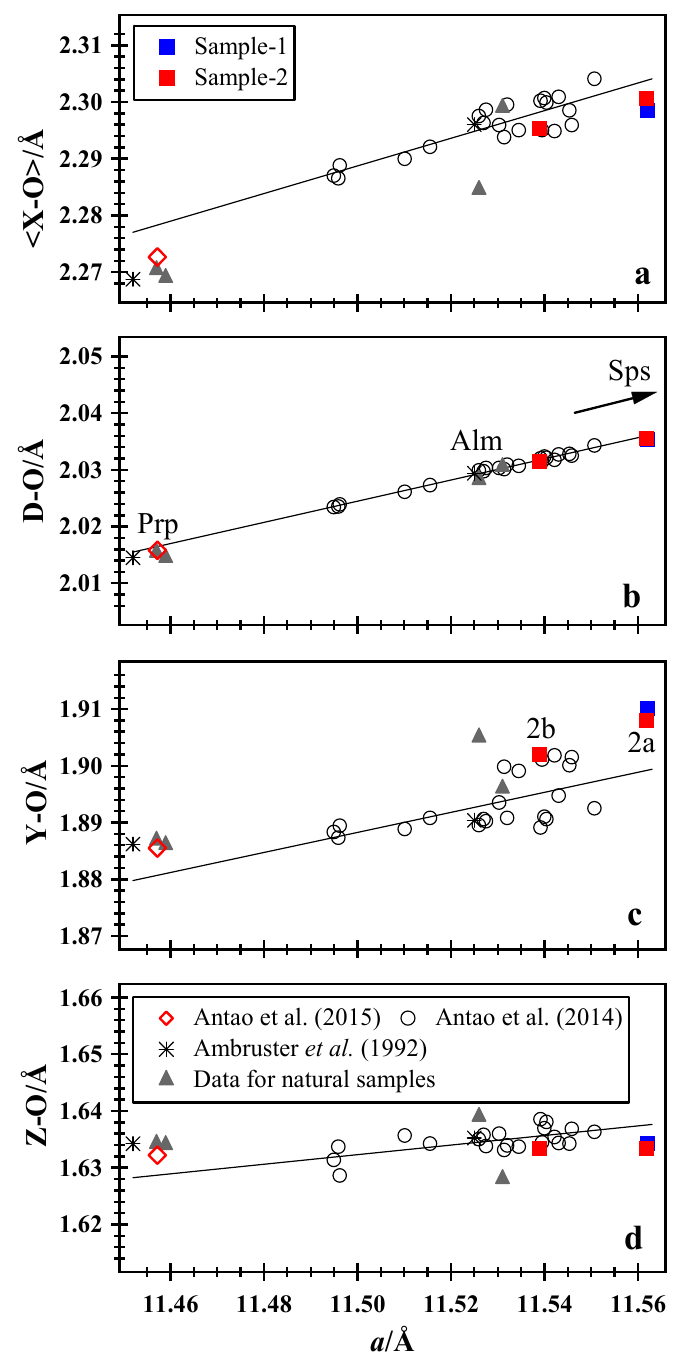
Figure 5. Structural variations across the pyrope (Prp)-almandine (Alm) series extended toward spessartine (Sps). The Y-axis interval (0.046 Å) is set the same in ( a – d ). Linear solid trend lines are fitted to the open circle data points from Antao et al. [80]. Other data from the literature are shown as triangles ( a = 11.457 Å (Prp)) from Merli et al. [61]; a = 11.459 Å (syn. Prp) and a = 11.531 Å (Alm) from Novak and Gibbs [27]; a = 11.526 Å (Cr-Prp) from Novak and Meyer [81], and black * ( a = 11.452 for syn. Prp and a = 11.525 Å for syn. Alm from Armbruster et al. [30]). The red open diamond denotes a synthetic Prp from Antao et al.